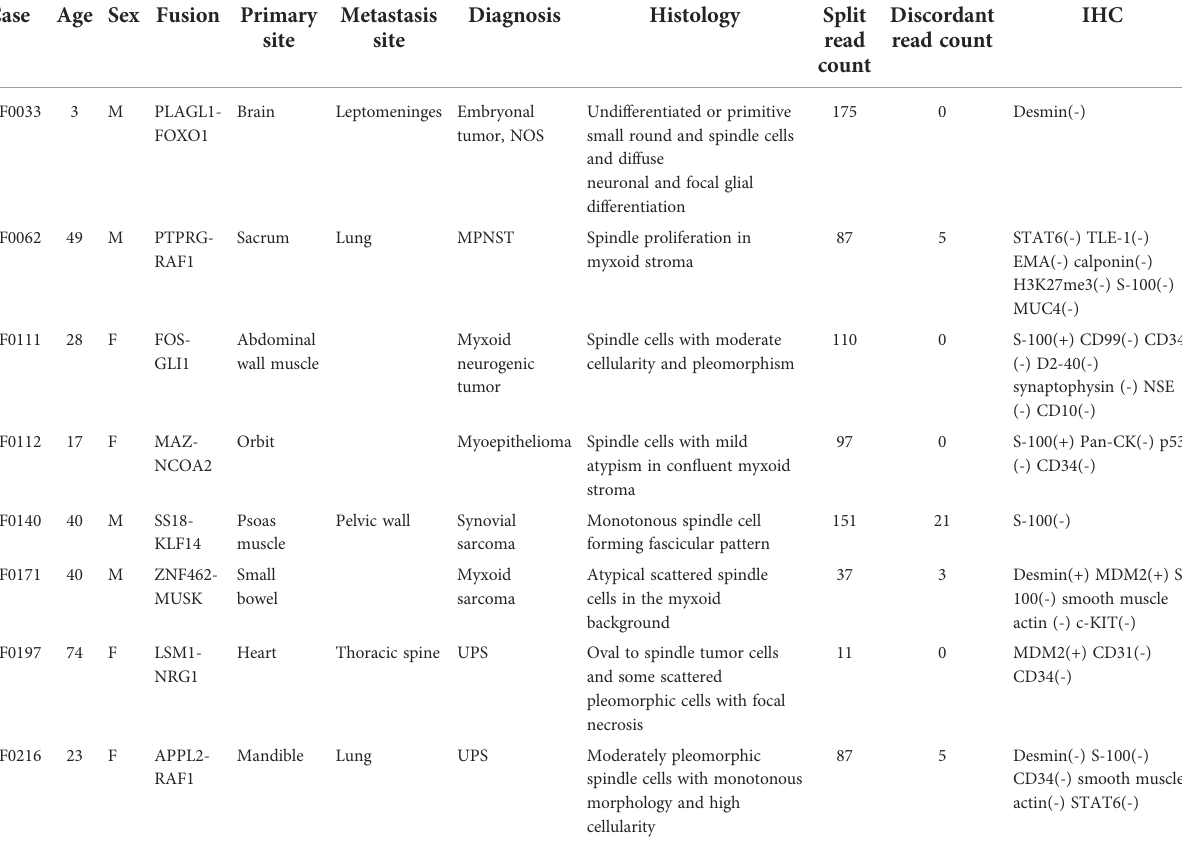
TABLE 2 Clinical characteristics of the cases in which novel fusions were